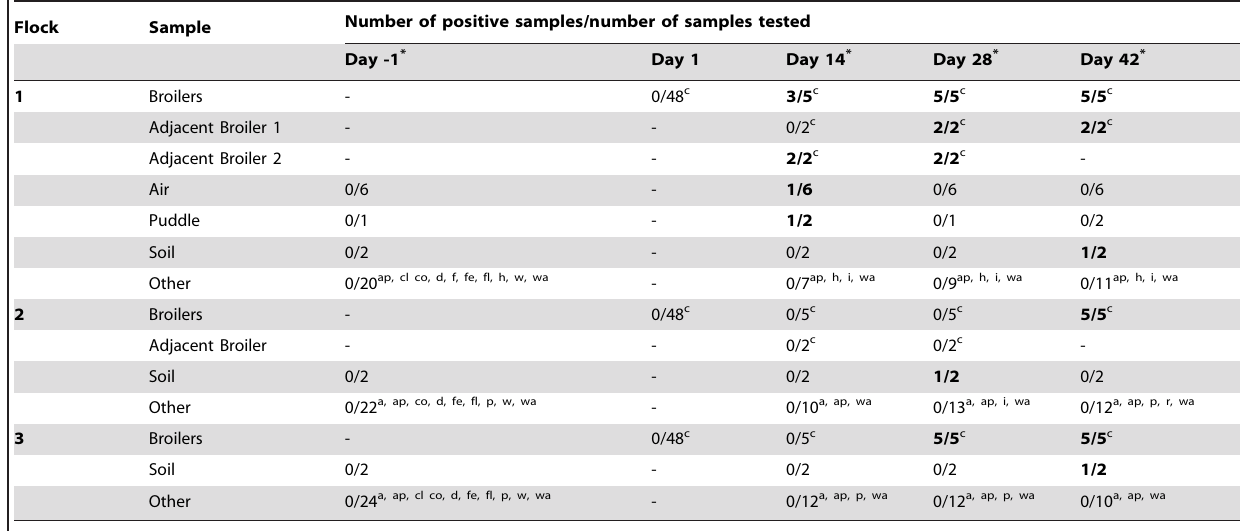
Table 1. Campylobacter sources during the sampling period across